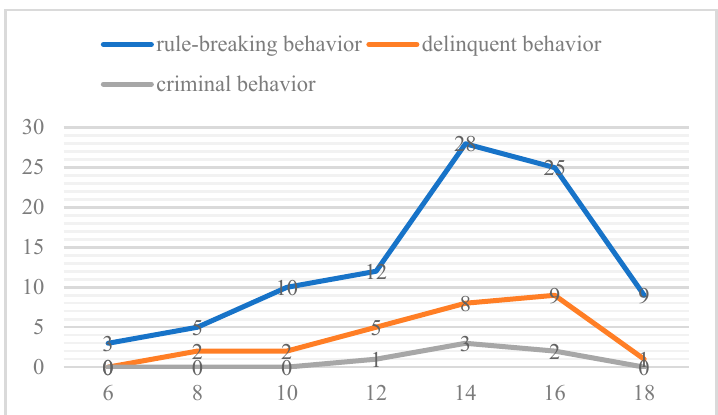
Figure 1. Frequency of antisocial behavior in children of different ages.